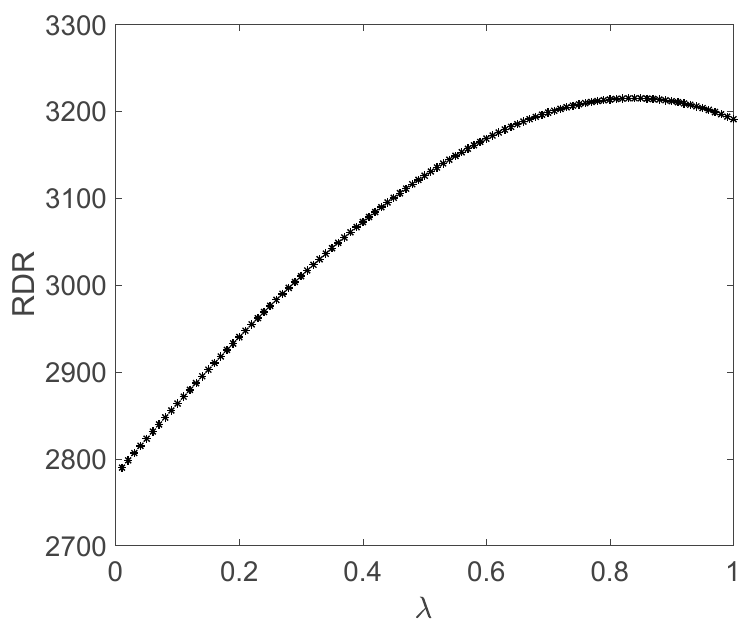
Figure 10. RDR vs. 𝜆 for a first-order plus dead-time process. Figure 10. RDR vs. λ for a first-order plus dead-time